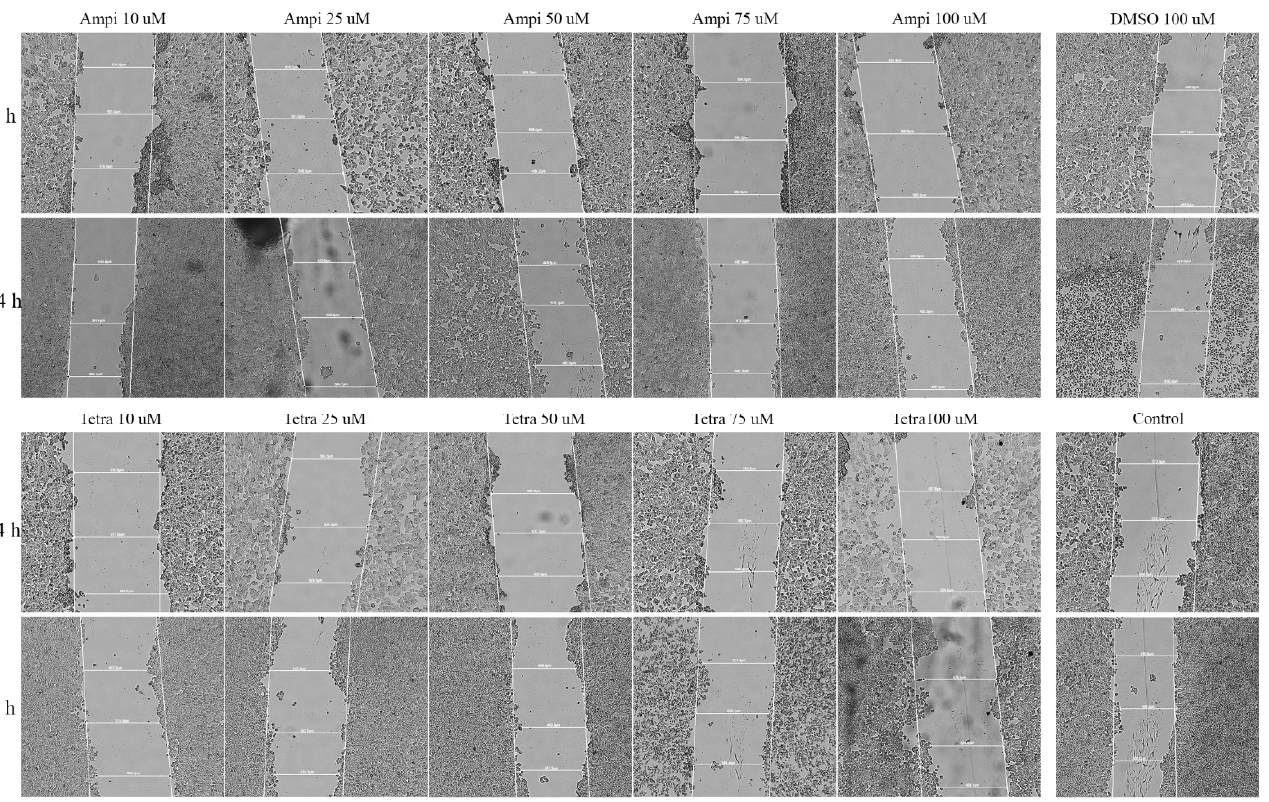
Figure 5. Representative images of the HT-29 scratch assay. Images were captured at 0 and 24 h after stimulation with tetracycline and ampicillin versus control cells. 20 × magnification.